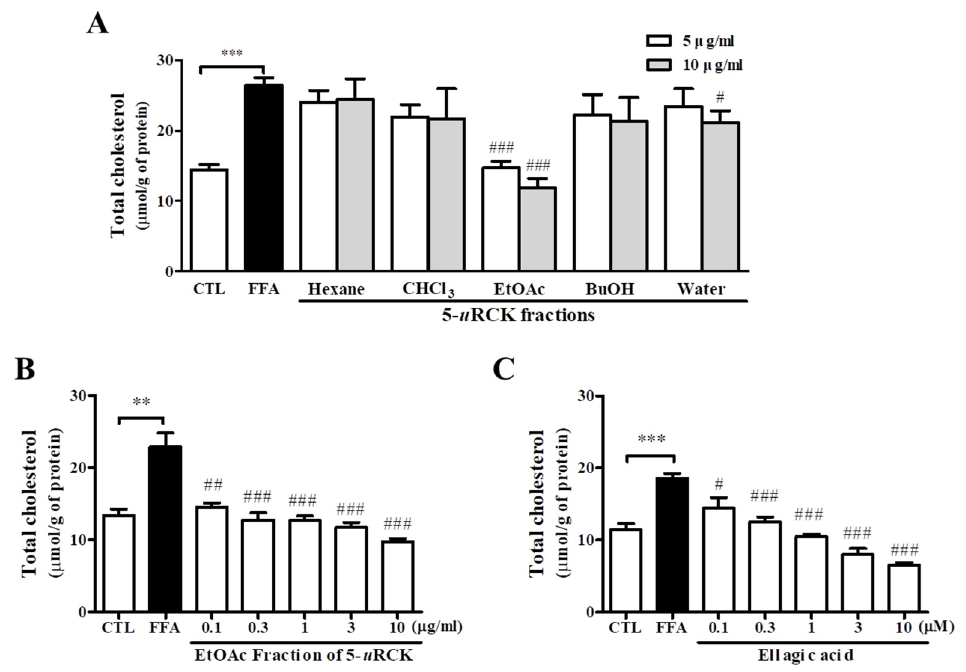
Figure 3. E ff ects of fractions of 5- u RCK or ellagic acid on cholesterol accumulation in FFA-induced HepG2 cells. HepG2 cells were treated with a 1 mM FFA mixture (oleic acid / palmitic acid, 2:1) and various concentrations of 5- u RCK fractions or ellagic acid for 24 h. ( A ) The e ff ect of various fractions of 5- u RCK or 5- u RCC on the intracellular total cholesterol content in FFA-induced HepG2 cells. ( B ) The e ff ect of the ethyl acetate fraction of 5- u RCK on the intracellular total cholesterol content in FFA-induced HepG2 cells. ( C ) The e ff ect of purified ellagic acid from 5- u RCK on the intracellular total cholesterol content in FFA-induced HepG2 cells. ** p < 0.01, *** p < 0.001 versus control (CTL). # p < 0.05, ## p < 0.01, ### p < 0.001 versus FFA-treated cells. The data are represented as the means ± SEMs.